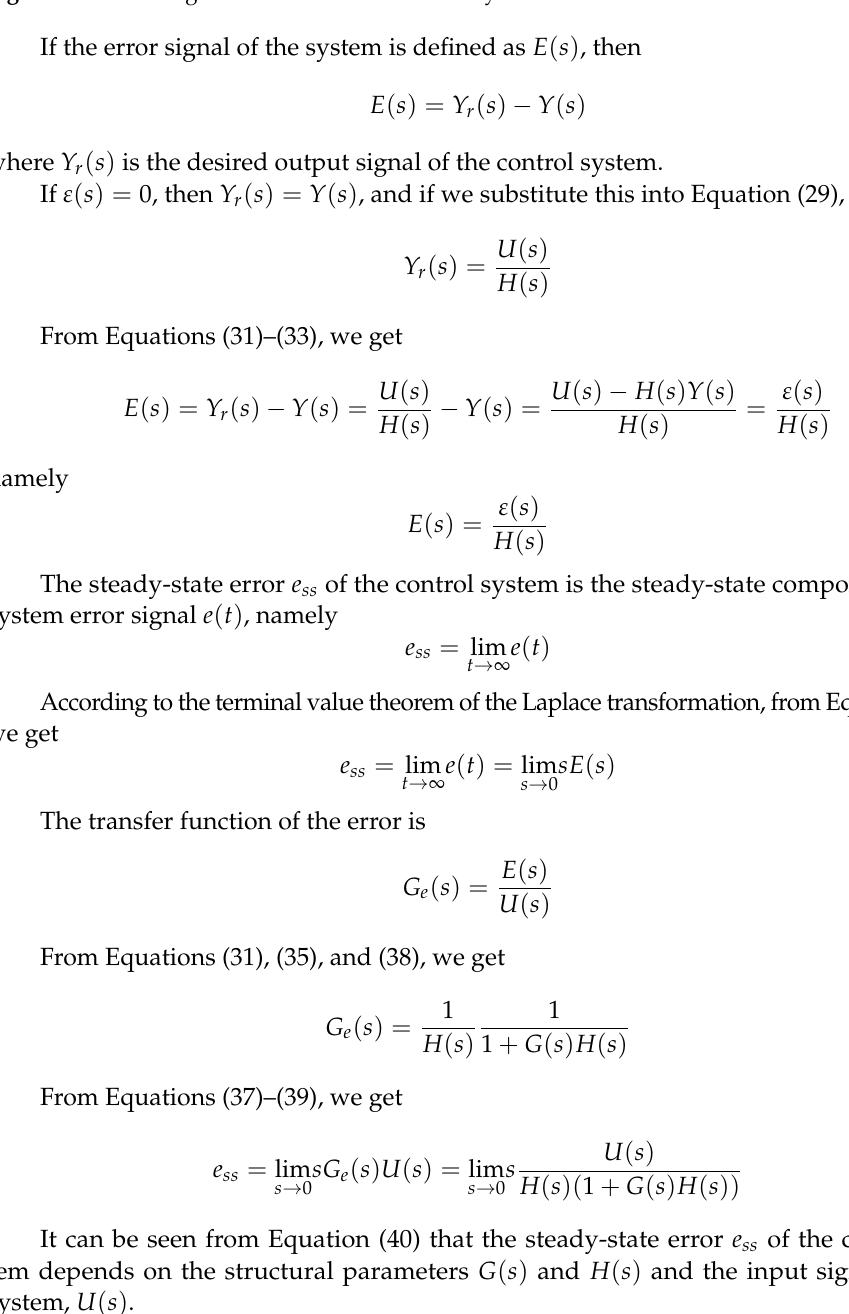
Figure 11. Block diagram of the feedback control